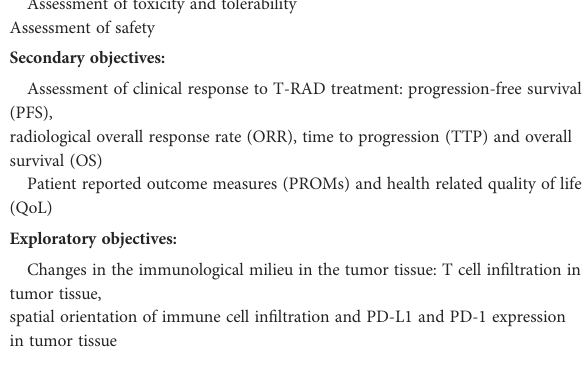
TABLE 1 Primary, secondary, and explorative objectives in the T-RAD study.